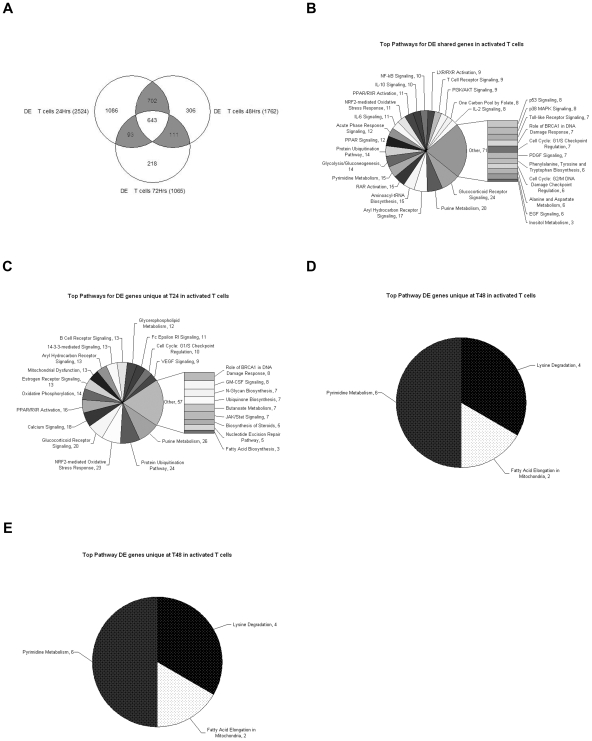
T cell genes differentially expressed (p<0.001) but without splicing that are common to all time-points populate a mix of immune/inflammation and metabolic pathways.(A) Venn diagram representing the differentially expressed genes with no alternative splicing (DE) detected at 24, 48, and 72 hours in activated T cells, with total number of detected genes per time point shown in parenthesis, number of genes unique to each time point shown by the number inside the circle and number of genes shared between time points in the shaded overlapping areas, with number of genes detected at all three time points shown in the central overlap. (B–E) Pie charts representing the Ingenuity Pathway Analysis output for the top canonical pathways populated by DE genes during T cell activation: (B) shared at all time points, (C) genes unique to 24 hour time-point, (D) genes unique to the 48 hour time-point, (E) genes unique to the 72 hour time-point. Numbers next to pathway name indicate the number of detected genes that are assigned to each pathway. The size of each shaded slice is proportional to the number of genes per pathway compared to total number of genes per chart.